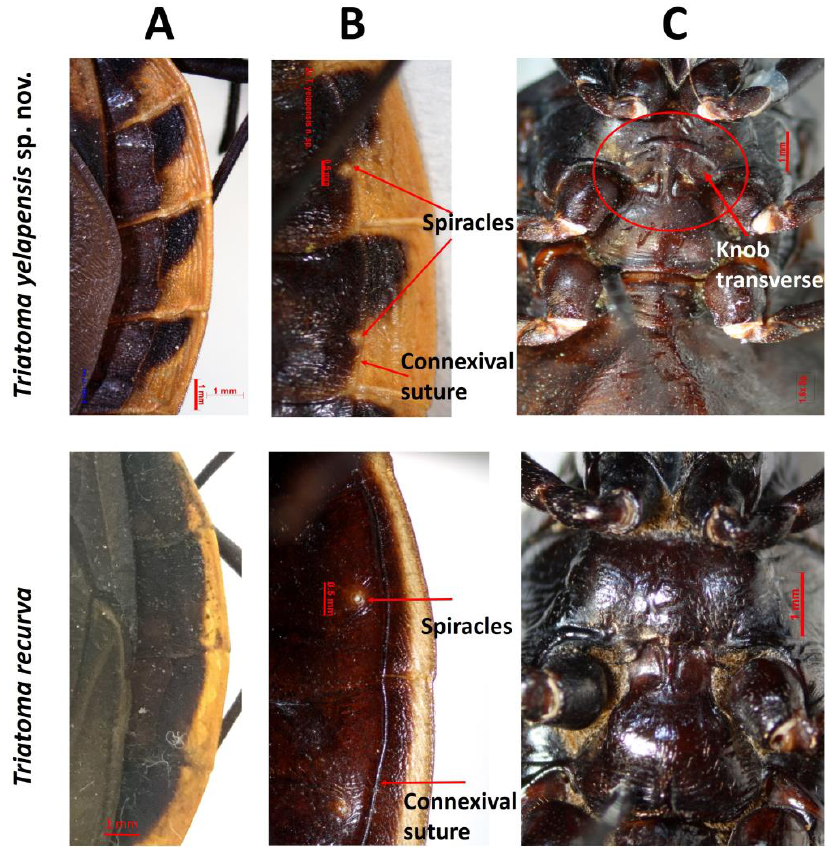
Insects 2023 , 14 , x FOR PEER REVIEW Figure 4. Connexivum and mesosternum of Triatoma yelapensis sp. nov. and Triatoma recurva . ( A ) Dorsal view of connexivum. ( B ) Ventral view of connexivum. ( C ) Ventral view of mesosternum. 3.2.2. Morphological Features Female total length 30 – 31 mm and male, 28 – 29 mm. Head longer than wide (1:0.38 – 0.40). Head length longer than the length of the pronotum (1:0.7 – 0.8). Ocellar lens 0.20 – 0.23 mm; width of eye shorter than synthlipsis (1:1.58 – 1.75). Ratio of labial segments 1:1.54 – 1.77:0.41 – 0.45. Pronotum glabrous. Mesosternum with a transverse T-shaped knob on median portion. Spiracles adjacent to connexival suture (Figure 4). Fossula spongiosa present on fore tibia of males, absent in females. Pygophore globular, rugose transver- sally, marginate distally. Discoid-shaped and denticulate in anterior half, medium size (0.45 mm) (Table 1).